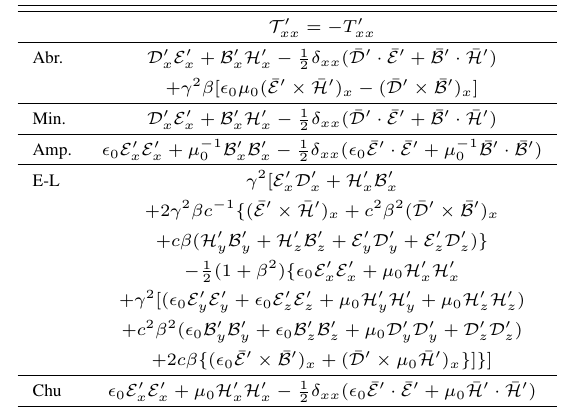
Table 3: Transformed stress